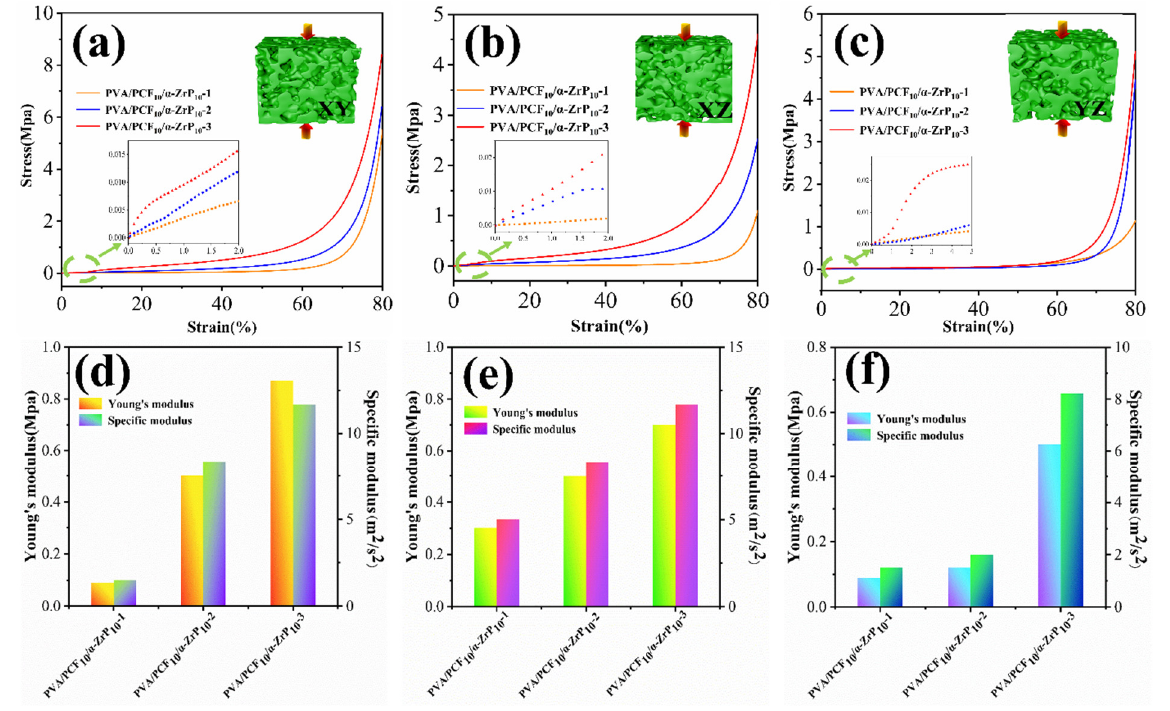
Figure 9. Compressive properties of the multi-directional PVA/PCF 10 / α -ZrP 10 -x aerogels. ( a – c ) Stress–strain curves in different directions; ( d – f ) Young’s moduli and specific moduli in different directions. The Young’s moduli and specific moduli of PVA-based composite aerogels are summa- rized in Figure 9d–f. The densities of the PVA/PCF 10 / α -ZrP 10 -1, PVA/PCF 10 / α -ZrP 10 -2, and PVA/PCF 10 / α -ZrP 10 -3 aerogels were 0.058 g/cm 3 , 0.056 g/cm 3 , and 0.05 g/cm 3